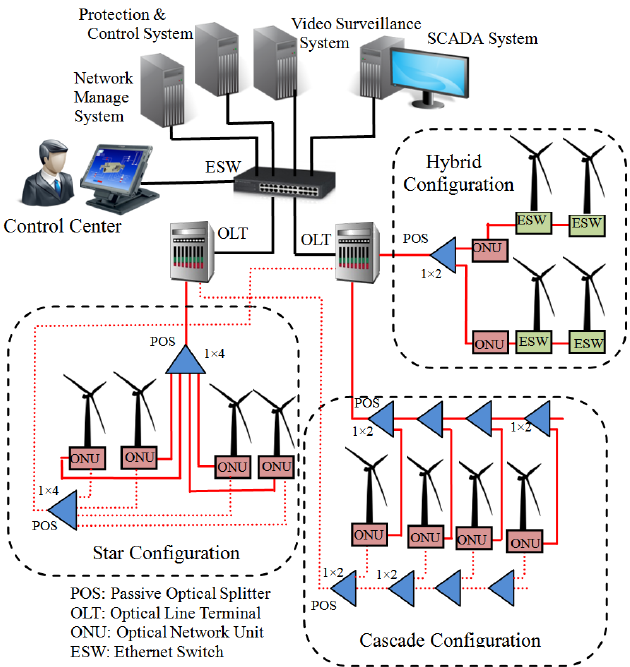
Figure 2. Schematic view of proposed Ethernet Passive Optical Network (EPON) communication network for WPF.